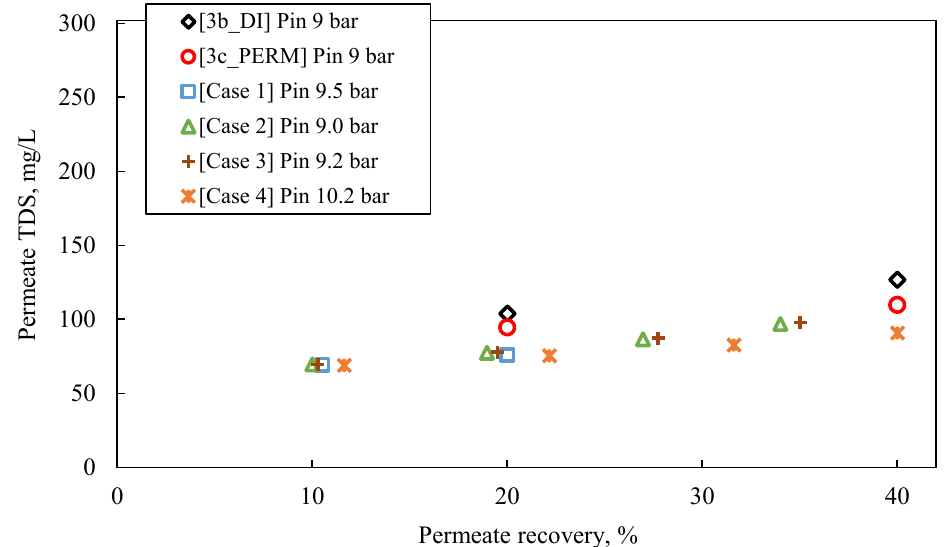
Figure 8. Experimental data (tests #3b_DI and #3c_PERM) of permeate flux temporal variation, compared with results obtained from SWM simulator (Cases 1–4); Feed: S5.